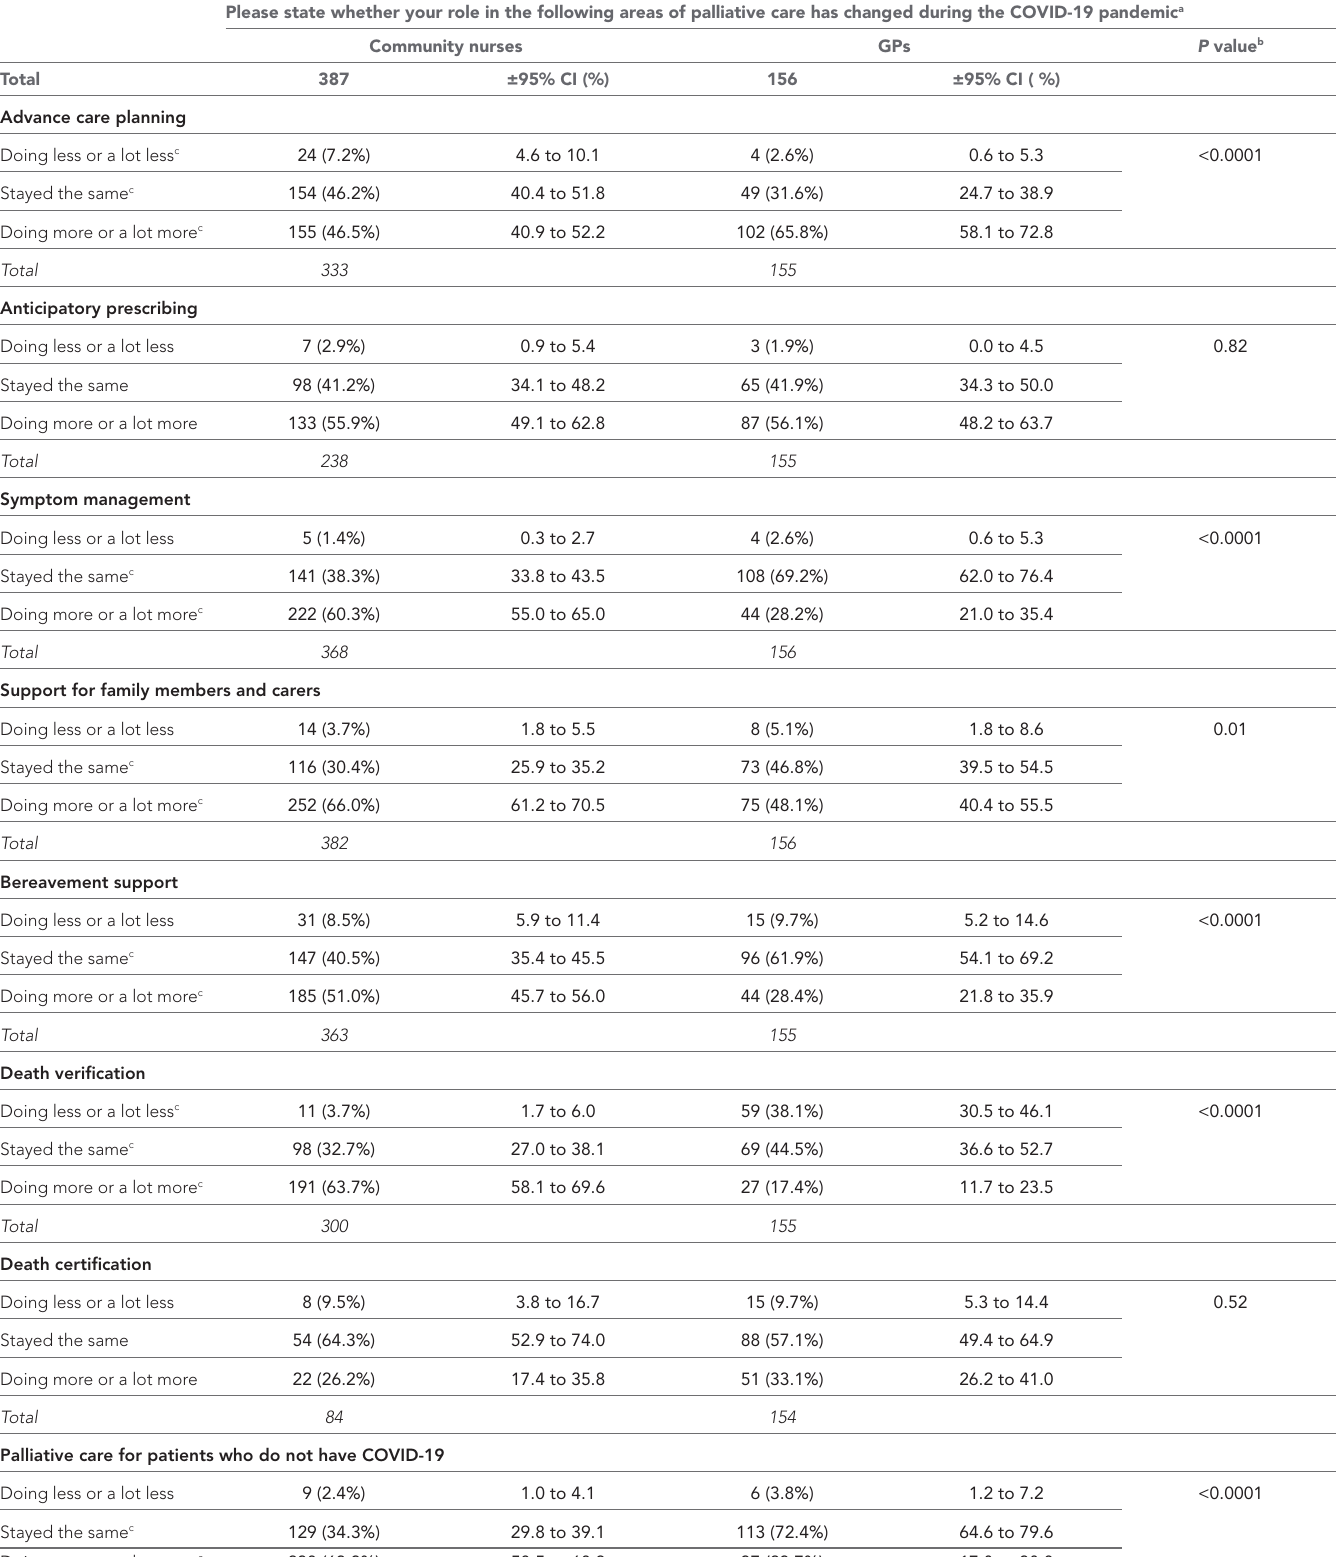
Table 2 Comparison between community nurses' and doctors’ responses for their professional role in palliative care activities Please state whether your role in the following areas of palliative care has changed during the COVID-19 pandemic a Community nurses